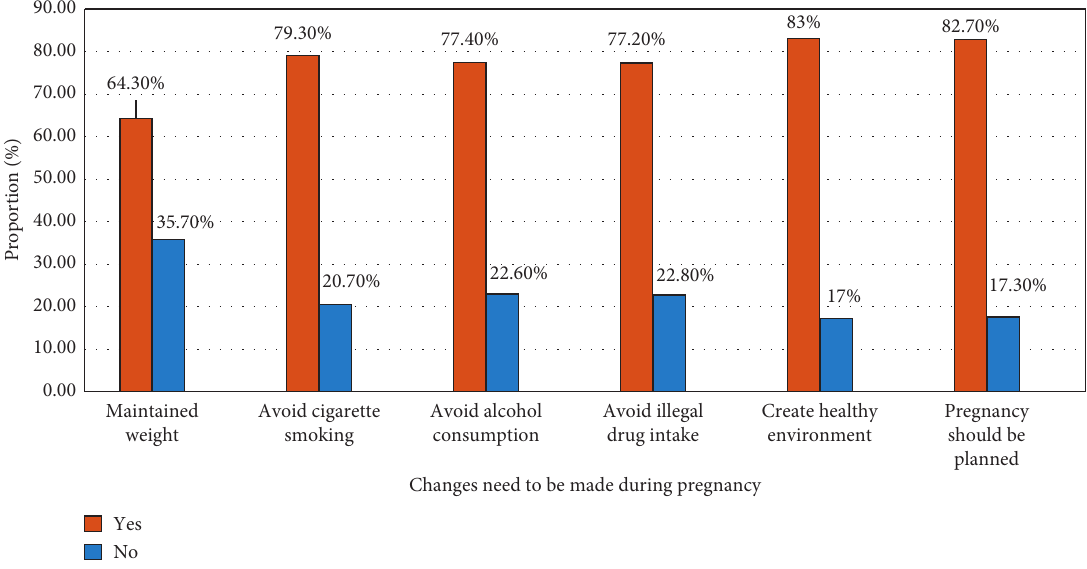
Figure 3: Women’s knowledge of preconception care component in Jinka town, Southern Ethiopia, 2018. Table 4: Factors associated with knowledge of preconception care among women in Jinka, Southern Ethiopia, 2018 ( n � 513).